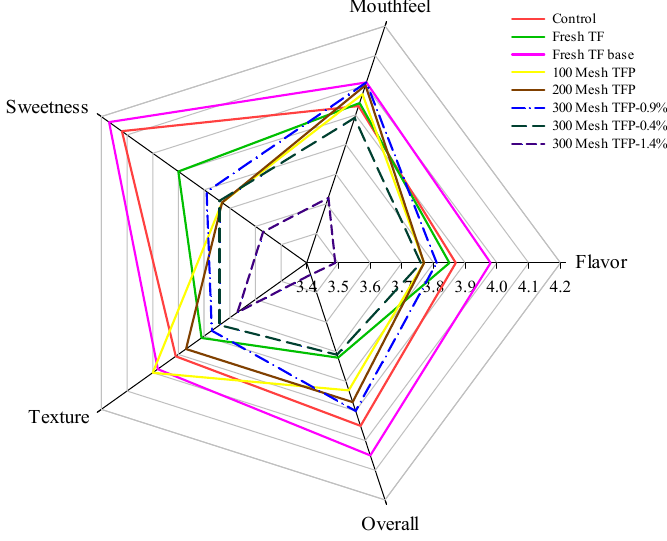
Figure 2. Sensory scores of T. fuciformis ice creams.